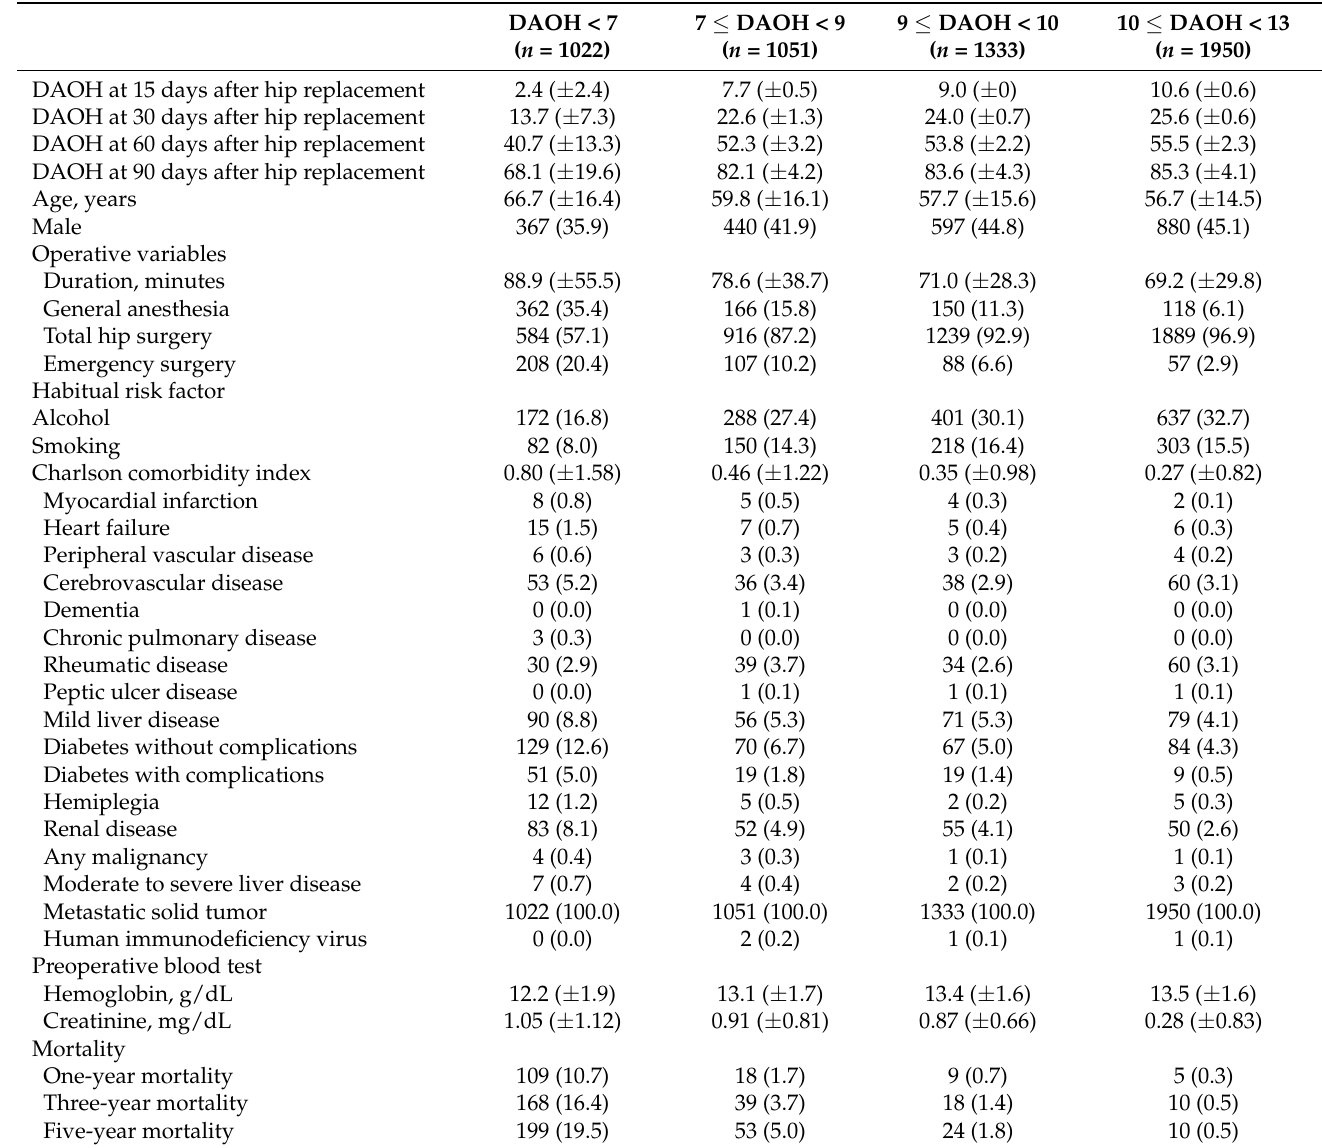
Table 1. Baseline characteristics and mortality according to quartile values of days alive and out of hospital